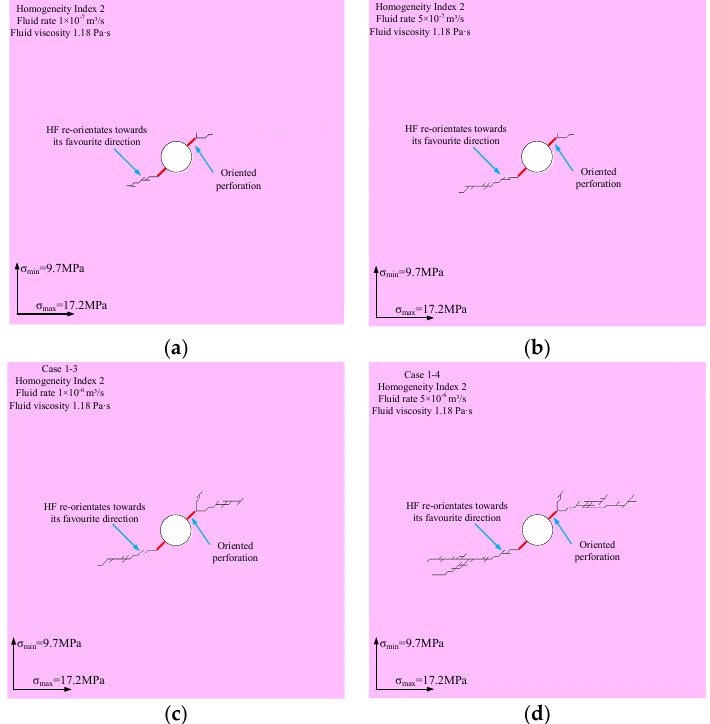
Figure 7. The relationship between HF re-orientation and fluid rate when the homogeneity index is equal to 2: ( a ) fluid rate is 1 × 10 − 7 m³/s; ( b ) fluid rate is 5 × 10 − 7 m³/s; ( c ) fluid rate is 1 × 10 − 6 m³/s; ( d ) fluid rate is 5 × 10 − 6 m³/s.